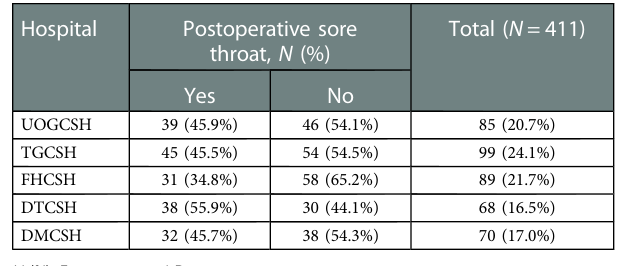
TABLE 3 The distribution of patients in each hospital in frequency and percentage at Northwest Amhara Referral Hospitals, from March 1 to June 30, 2022( N =411).